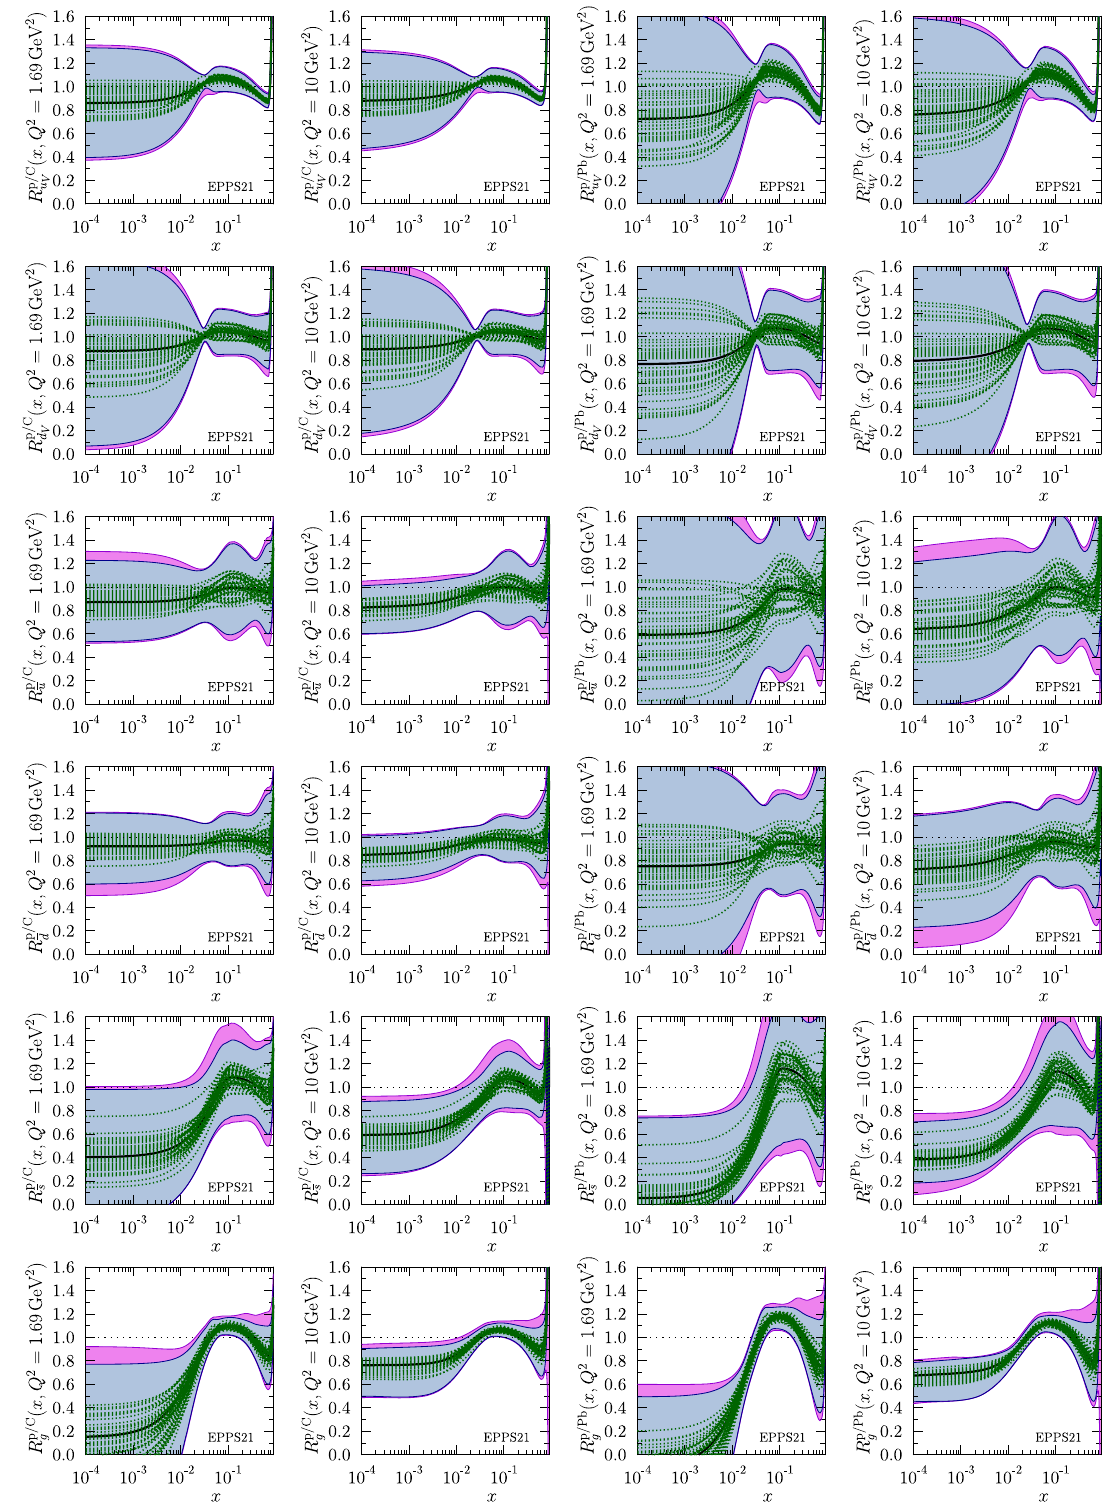
Fig. 7 The EPPS21 nuclear modifications of bound protons in carbon (two leftmost columns) in lead (two rightmost columns) at the initial scale Q 2 = 1 . 69GeV 2 and at Q 2 = 10GeV 2 . The central results are shown by thick black curves, and the nuclear error sets by green dotted